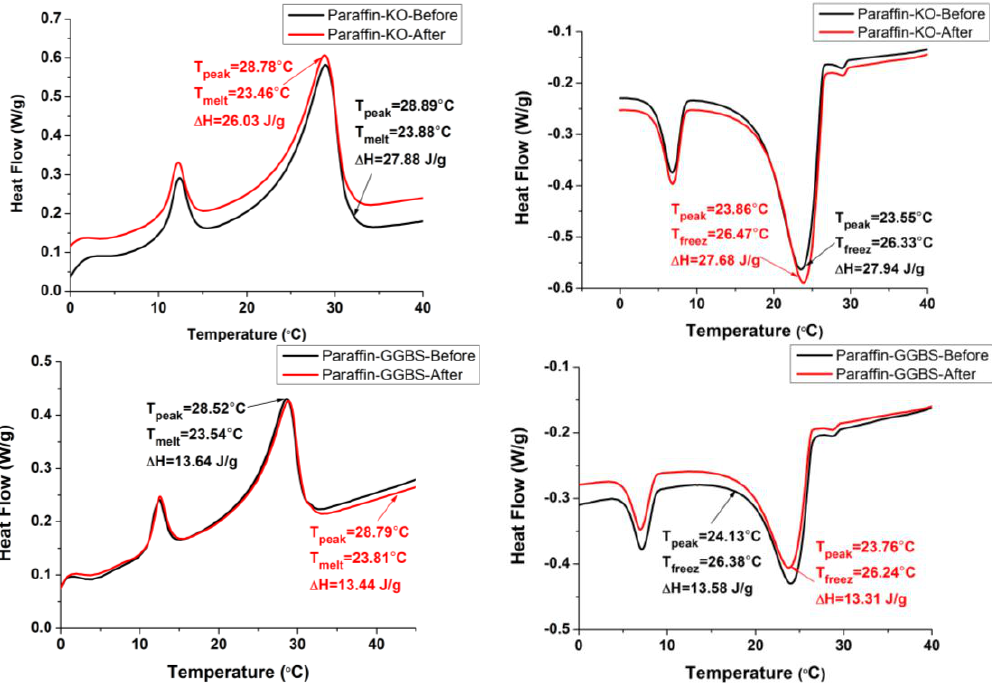
Figure 10. DSC thermograms of CPCMs before and after thermal